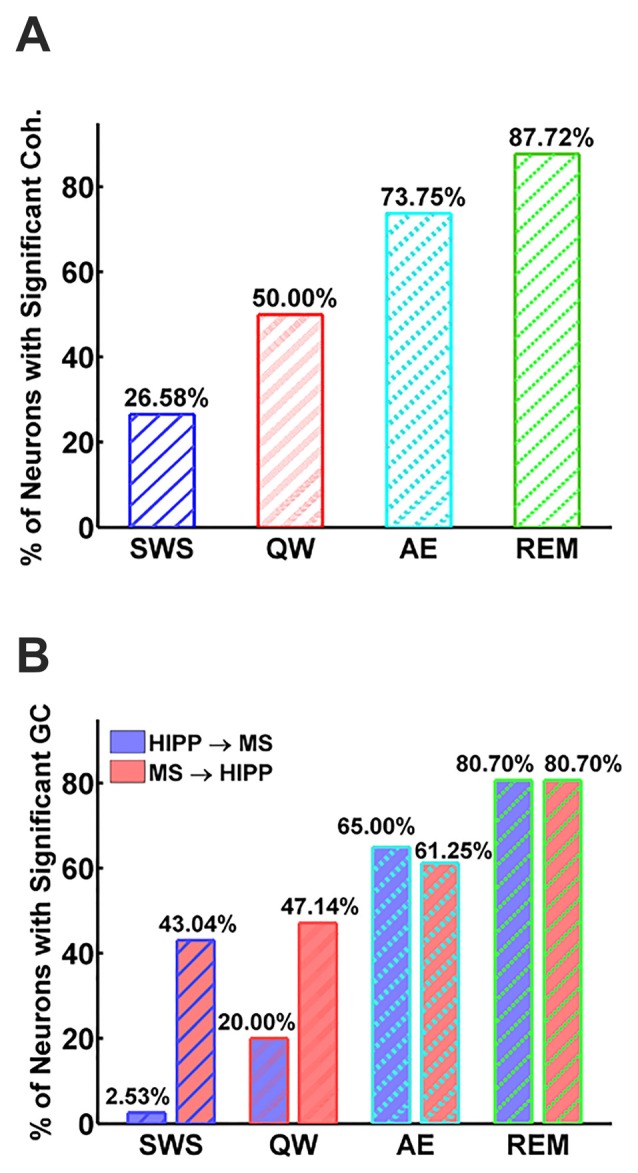
Percentage of neurons with significant MS-Hipp coherence (A) and significant MS→HIPP or HIPP→MS Granger causality (GC; B).